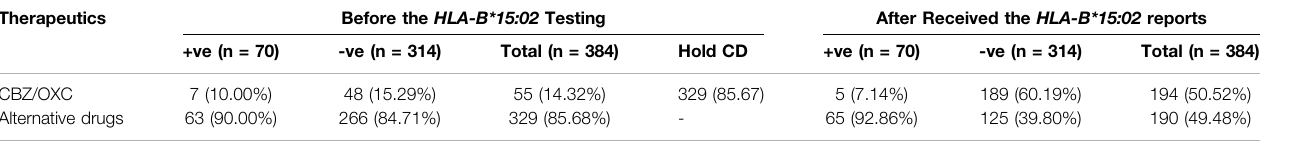
TABLE 2 | Clinical decision on CBZ/OXC usage before and after received the HLA-B*15:02 PGx testing. Therapeutics Before the HLA-B*15:02